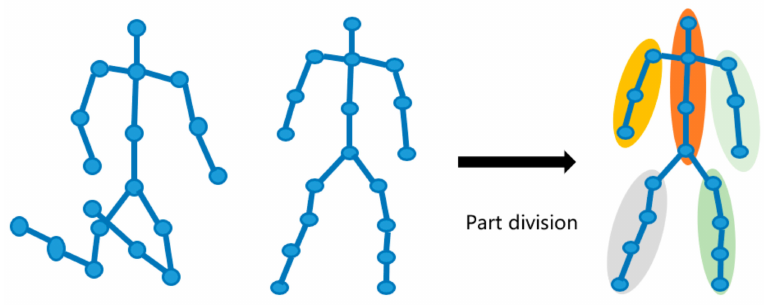
Figure 1. Schematic diagram of a fall and sub-graph